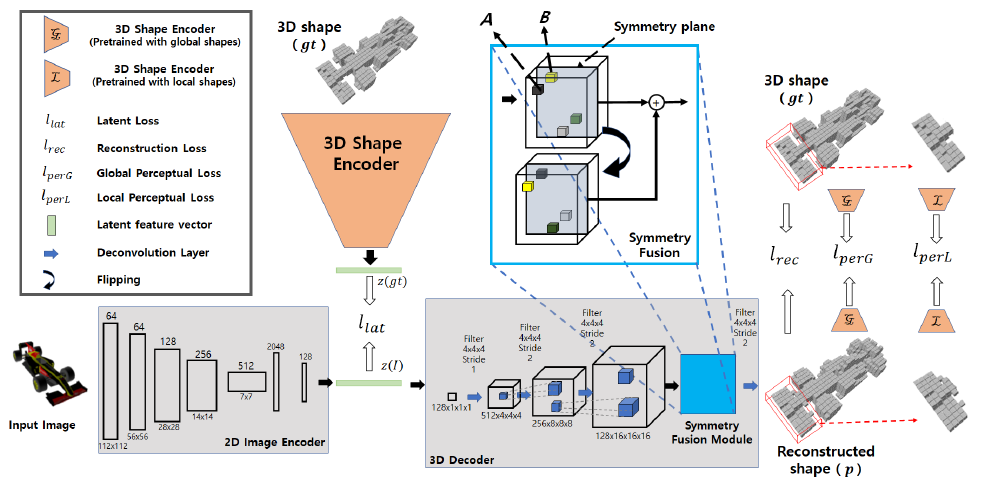
Figure 2. Proposed symmetry 3D prior network: During first stage of our training, the 3D shape encoder and 3D decoder are trained to learn latent space representation of 3D shapes. In second stage, the 2D image Encoder is trained with a pre-trained 3D decoder to learn the mapping between 2D and 3D representations in latent space. Finally, perceptual loss is applied together with latent loss and reconstruction